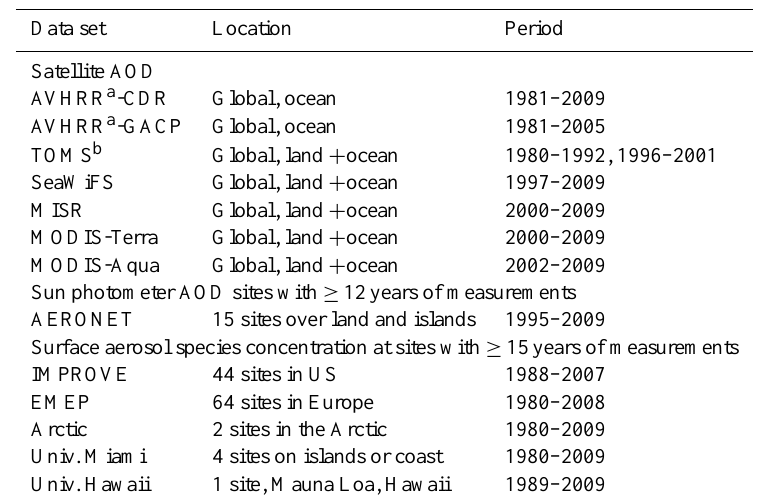
Table 3. Observation data used in the present